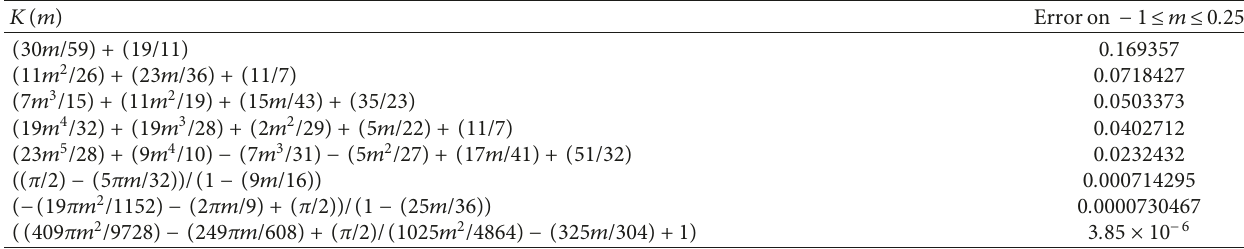
Table 1: Approximations for the elliptic integral K ( m ) � 􏽒 π /2